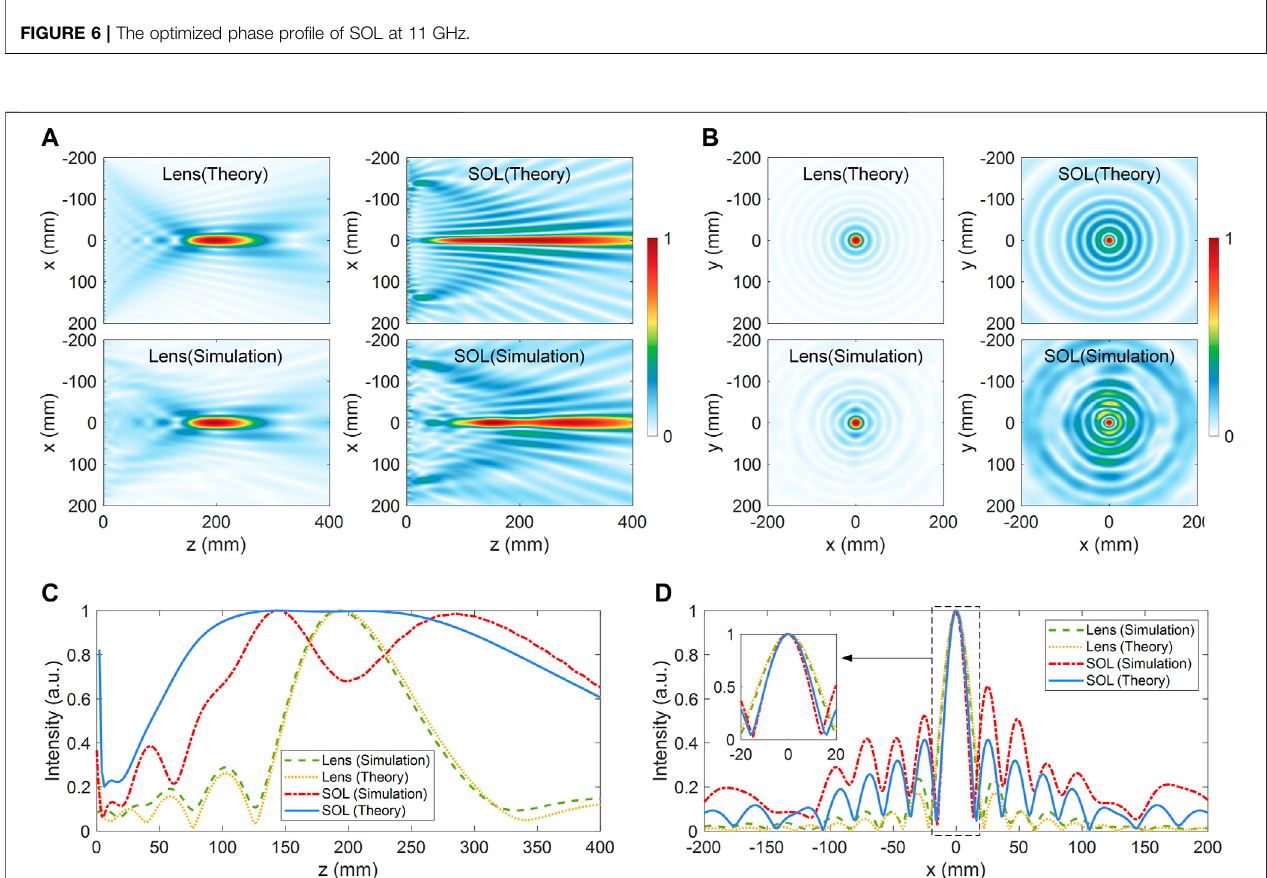
FIGURE 7 | Theoretical calculated and simulated normalized E x fi eld distribution in (A) the XZ plane at y (cid:1) 0 mm and (B) the XY plane at z (cid:1) 200 mm (11 GHz). Normalized intensity of E x along (C) the optical axis, and (D) the x-axis at the focal plane, the inset is a partially enlarged view of focal spot intensity.